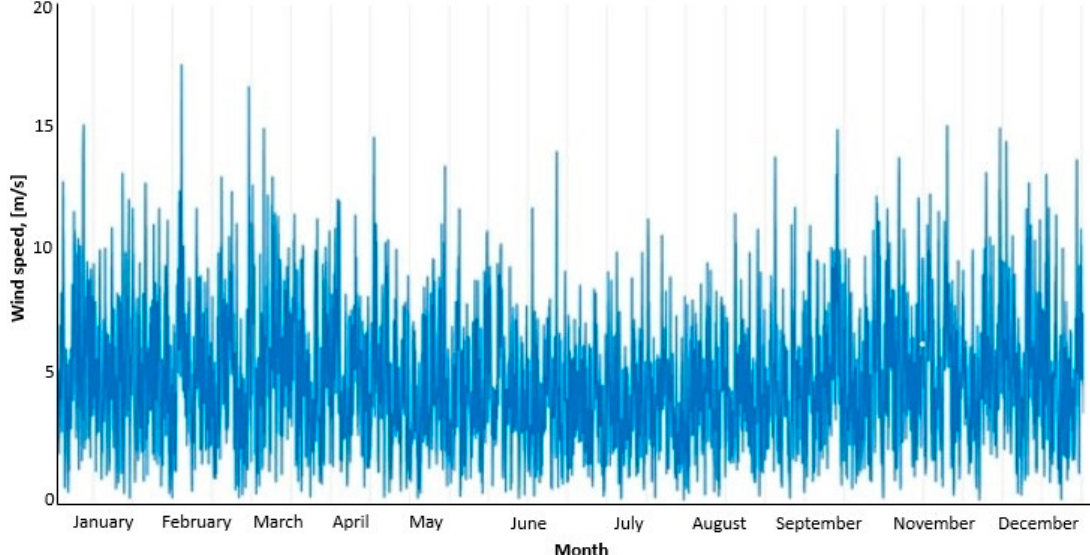
Figure 6. Annual wind distribution speed in Suceava County region [27].